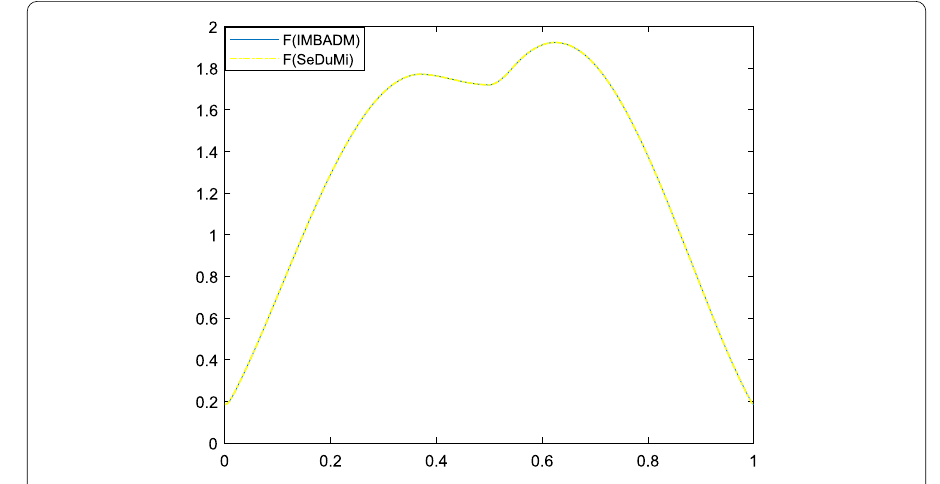
Figure 3 Comparative results of force F by the two